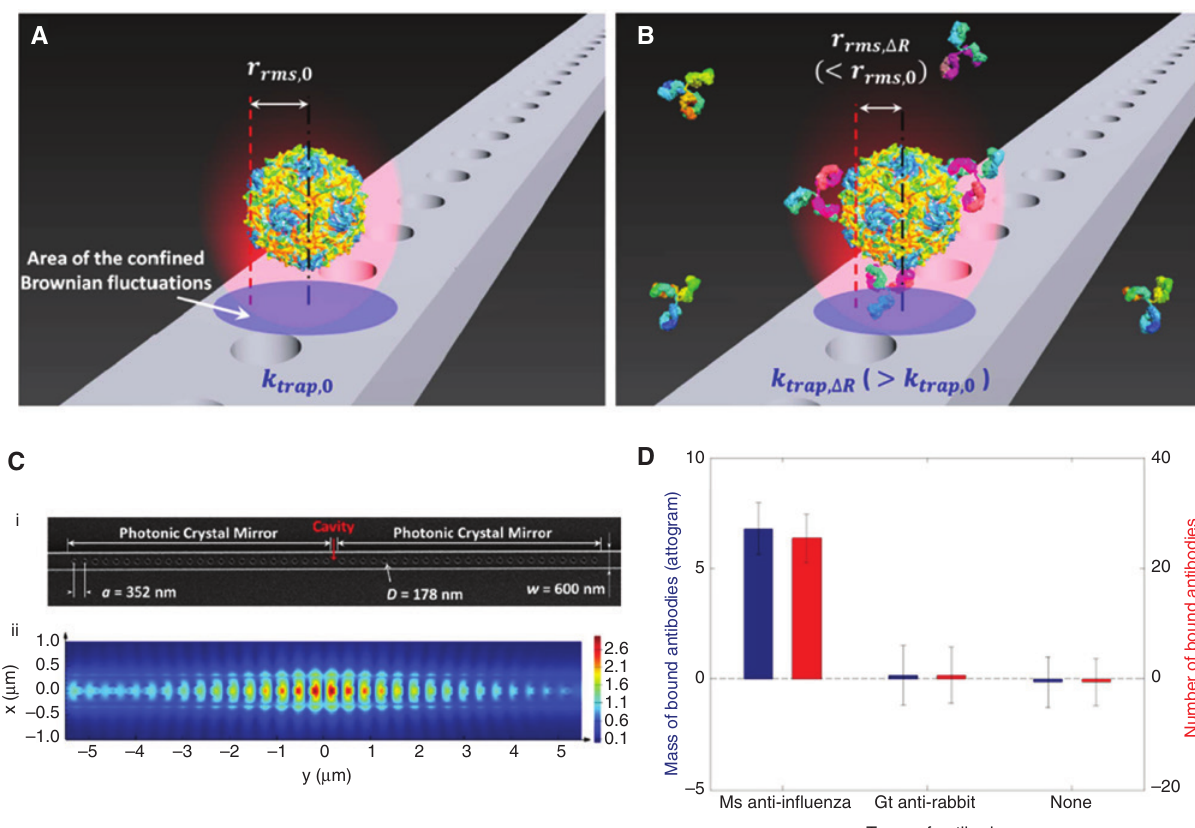
Figure 27: Optical trap to inspect interactions between a single H1N1 influenza virus and specific antibodies. (A) and (B) Label-free detection of binding interactions between (A) a single influenza virus and (B) binding anti-influenza antibody in a nanophotonic near-field trap. The subscript 0 denotes an initial measurement and subscript Δ R denotes the measurement at equilibrium. Models from the Protein Data Bank Embedded Python Molecular Viewer open-source plug-in were used for the illustration. (C) SEM image of the nanobeam PhC resonator and computed strong field confinement within the resonator nanocavity in (C). (D) Stoichiometry of the studied binding antibodies using the density and mass of bound biomolecules. Adapted from